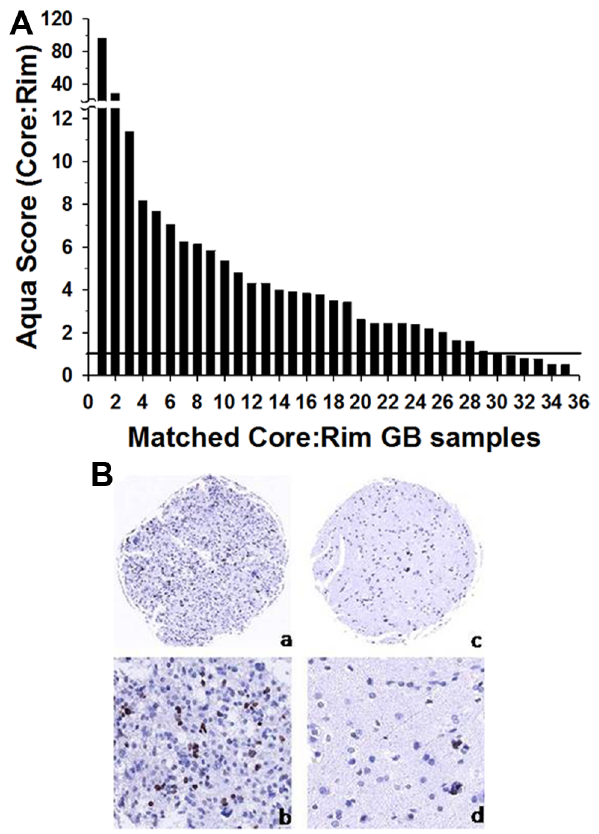
Figure 2. Quantitative analysis of Ki-67 expression in 35 human glioma tumors. (A) AQUA scores of Ki-67 protein levels were measured in matched sets of core:rim for each tumor; ratio of AQUA scores for each specimen are plotted, ranked from high to low. Samples with an AQUA score fold difference above ‘‘1’’ indicates significant up- regulation (indicated by horizontal line) (p , 0.002). (B) Representative images of the Ki-67 (MIB-1) immunostaining of the GBM core (a, b) and invasive rim (c, d). Original magnification 10x (a,c) and 20x (b,d).